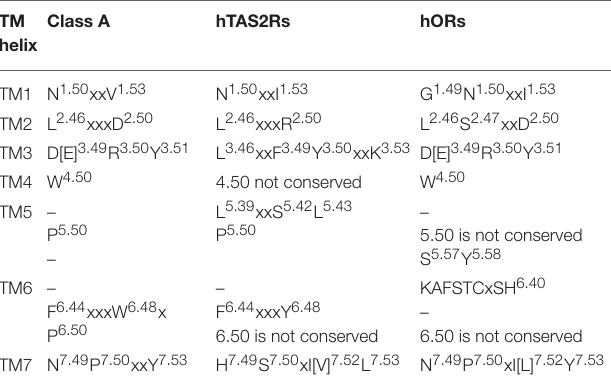
TABLE 1 | Shared conserved motifs between Class A GPCRs (Lagerstrom and Schioth, 2008; Venkatakrishnan et al., 2013; Tehan et al., 2014), hTAS2Rs (Pydi et al., 2014a, 2016; Di Pizio et al., 2016), and hORs (de March et al.,